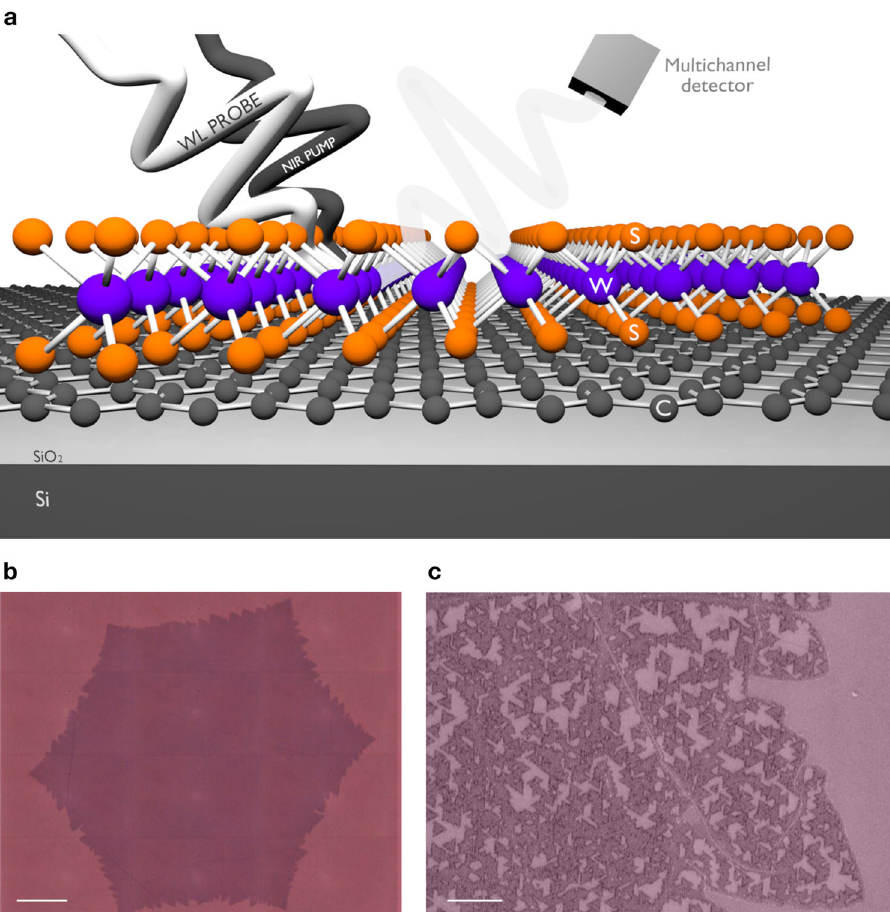
Fig. 1 Sample structure. a Schematic of the WS 2 /graphene heterostructure on SiO 2 /Si substrate photoexcited by an ultrashort near-IR pulse. The white light probe is re fl ected by the substrate and collected onto a multichannel detector. b Optical image of the graphene fl ake after transfer on the SiO 2 /Si substrate. The scale bar is 50 μ m. c Scanning electron microscope image of the HS sample after the CVD growth of WS 2 on graphene, showing triangular crystals of WS 2 . The scale bar is 2 μ